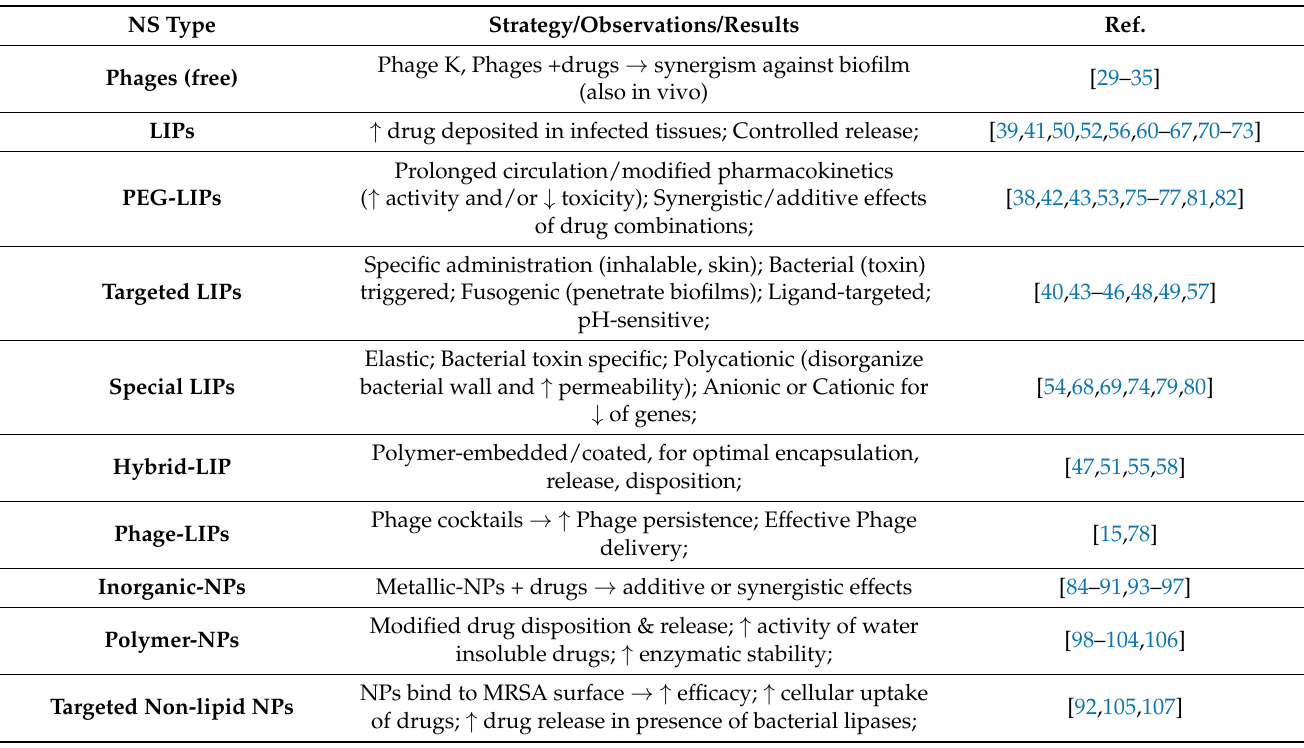
Table 2. Nanosystems for treatment of MRSA